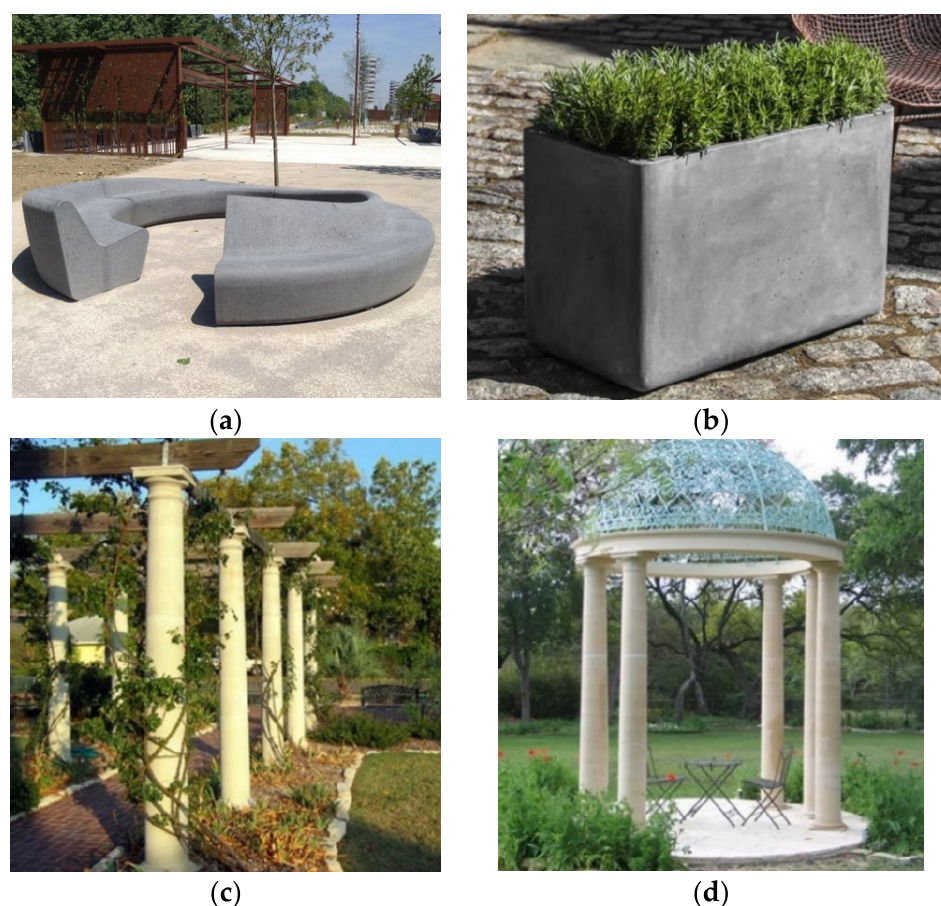
Figure 36. ( a ) GFRC bench [140]; ( b ) GFRC flower pot [141]; ( c ) GFRC pergola [142]; ( d ) GFRC gazebo